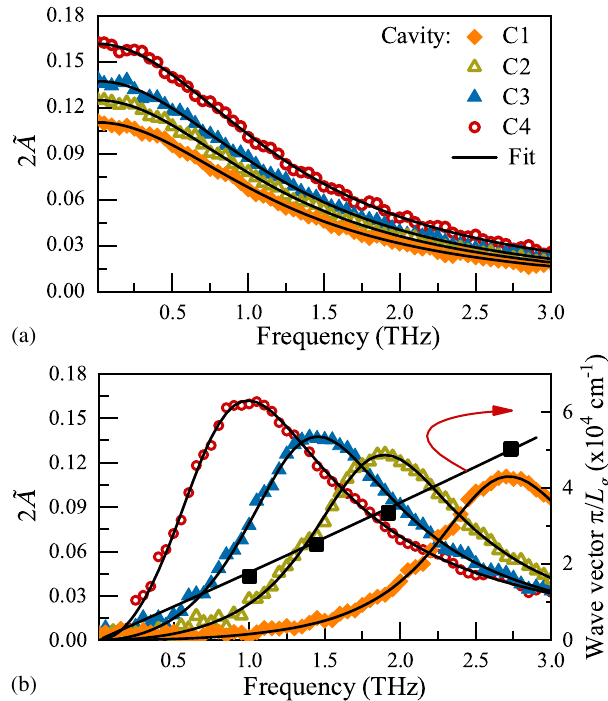
FIG. 5. Gate-length-dependent extinction spectra of the gra- ¼ 0 V with incident light polarized phene structures for U d parallel (a) and perpendicular (b) to the gate fingers. The measured data points and lines are the fits by the Drude model fit for parallel polarization and the damped oscillator model for perpendicular polarization. Black solid squares are a maximum of experimental resonant plasma frequencies as a function of the wave vector q ¼ π =L 1 . The black straight line through these dots is the best linear fit (right-hand